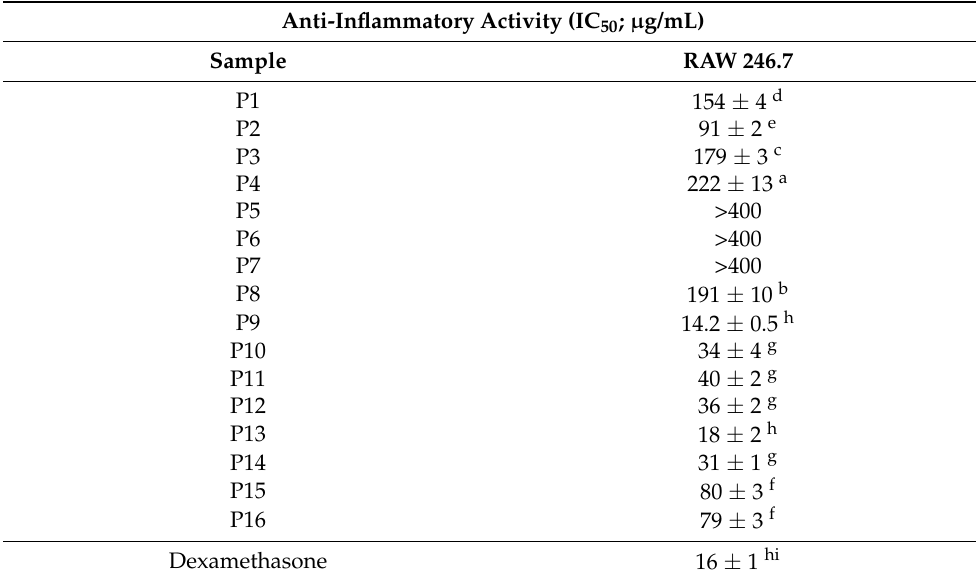
Table 4. Anti-inflammatory activity of the hydroethanolic extracts of cardoon